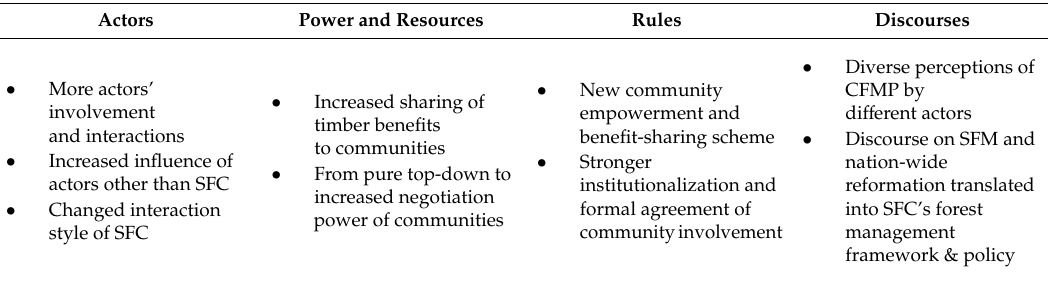
Table 2. Main changes by the Collaborative Forest Management